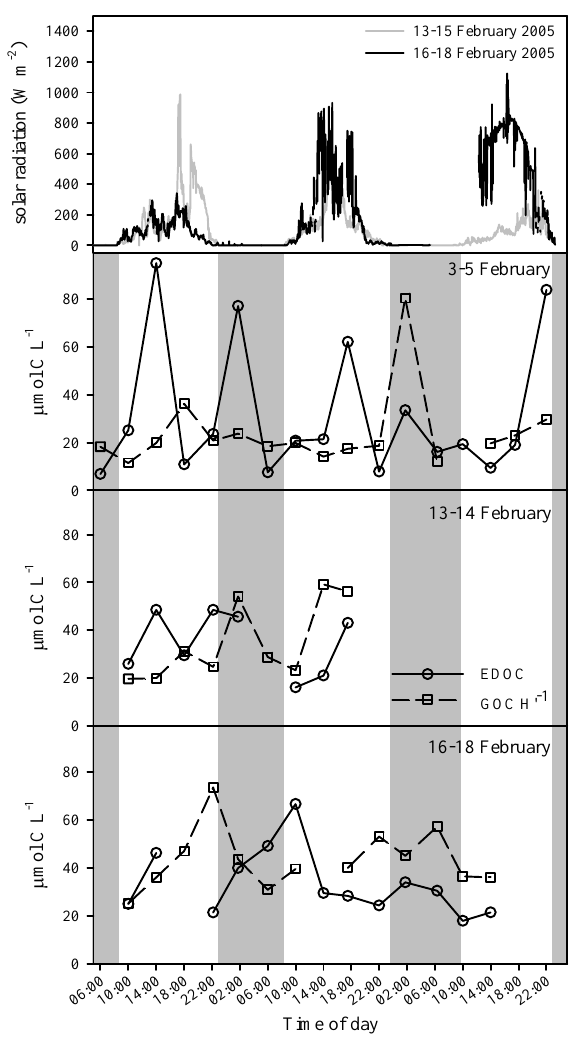
Figure 10. Diel variability of EDOC (solid line, open circles) and GOC H 0− 1 (dashed line, open squares). The top panel shows solar radiation for the different days sampled; data for the 3–5 February cycle are missing due to equipment failure.